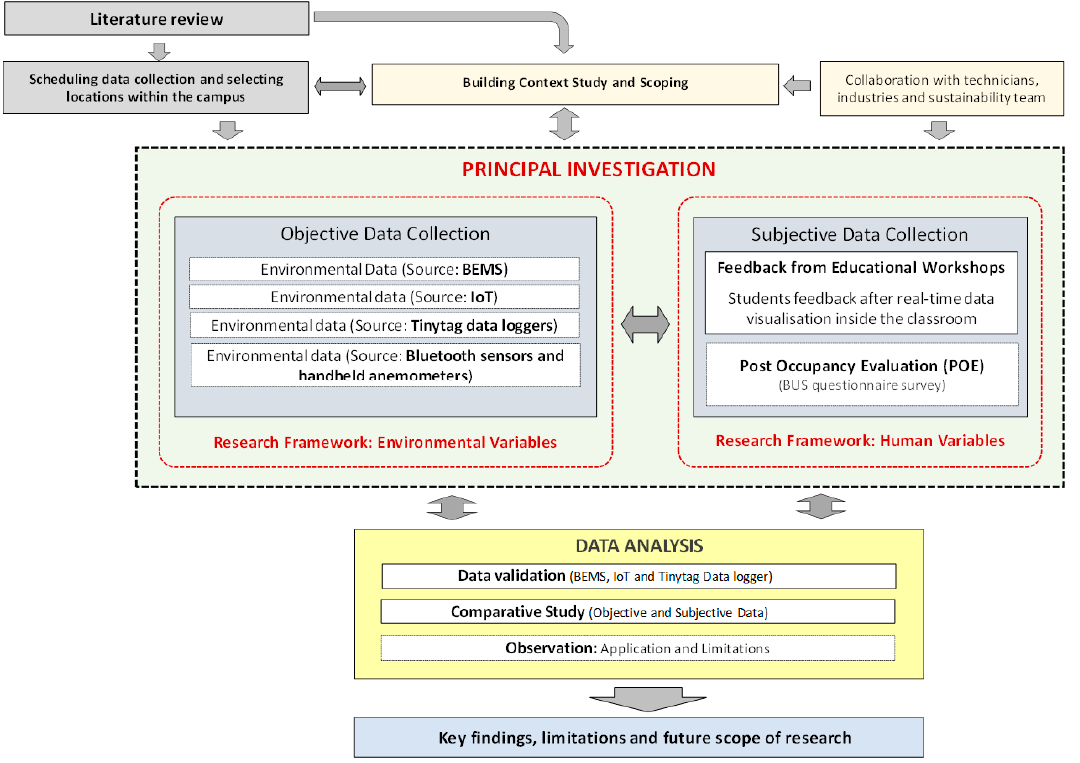
Figure 1. Flowchart showing the empirical research framework and the overall methodology.